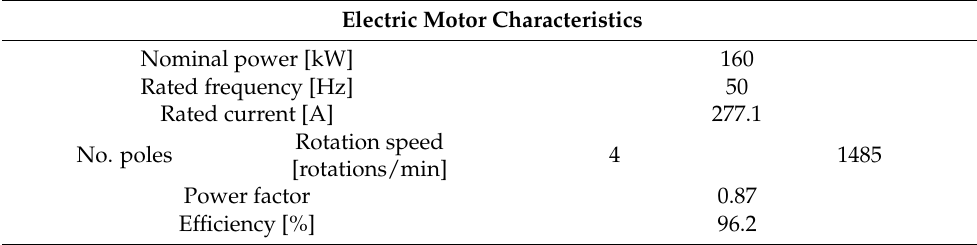
Table 3. The electric motor characteristics for vertical pumps from the pumping